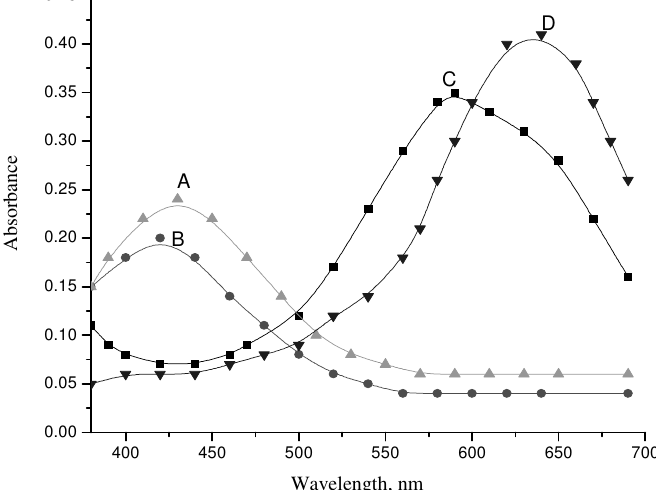
Figure 1. Absorption spectra of Th(IV) at pH 6.5, A) CRAS-(Reagent); B) CRAS- CDMEAB-(Modified reagent); C) CRAS-Th(IV) at(pH 4.5)-(Binary complex) and